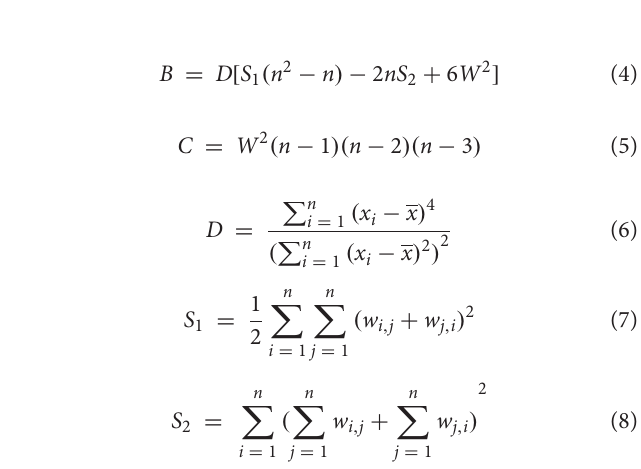
FIGURE 1 | Spatial depiction of ideal Moran’s I values: left- perfect dispersion, Moran’s I value = –1; middle- perfect randomness, Moran’s I value = 0; right- perfect clustering, Moran’s I value = +1.